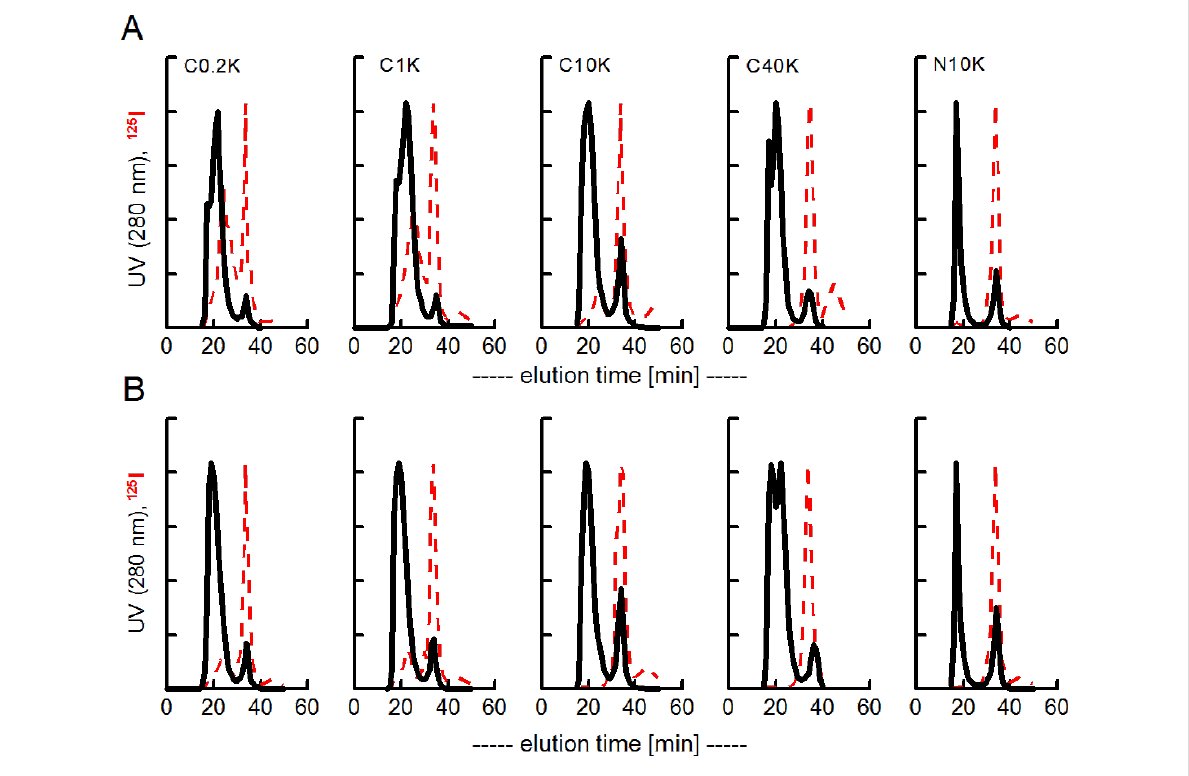
Figure 5: Stability of transferrin in a preformed corona on SPIOs with or without PEGylation (B). FPLC analyses of 125 I activity in fractions. A, trans- ferrin adsorbed; B, transferrin covalently bound. The N-PEGylated SPIOS (N10K) and the fully C-PEGylated SPIOs (C10, C40) do not adsorb 125 I- albumin. A, initial transferrin adsorbed; B, initial transferrin covalently bound. The peak at 33 min represents proteins with the size of transferrin (DLS: 9